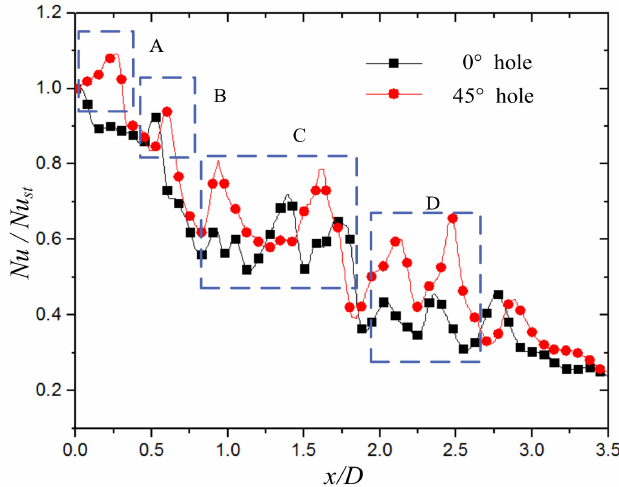
Figure 16. The distribution of Nu/Nu st in the x